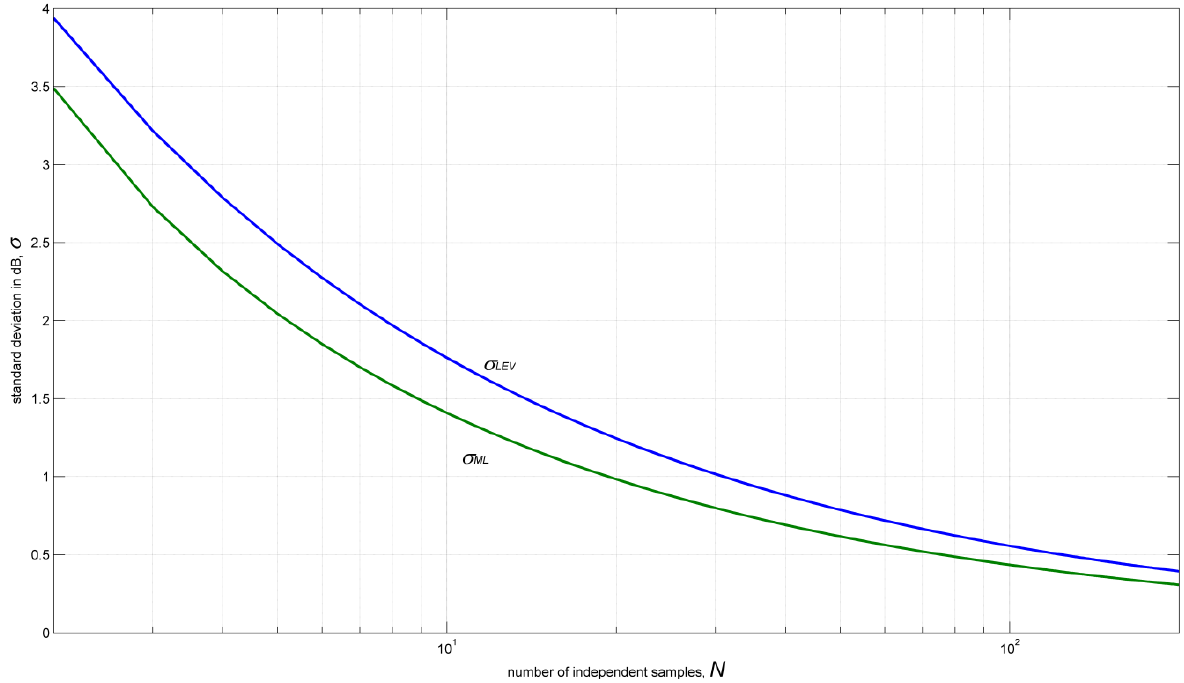
Figure 1. Expected standard deviation from an ensemble of N independent samples of Rayleigh-distributed echoes. When the power is linearly averaged, the corresponding variance (dB scale), is smaller than the variance obtained by averaging power on a decibel (dB) scale. In the picture, N , spans from 2 to 200. As can be seen from both Equations (8) and (10), when N  1, the intrinsic uncertainty tends to 5.57